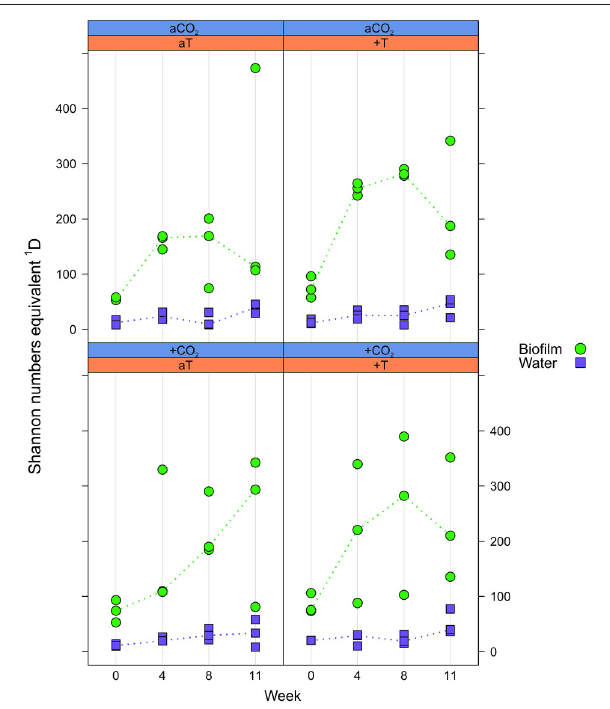
FIGURE 3 | Effective OTU richness. Distribution of Shannon number equivalents 1 D at OTU level concerning Fucus mytili biofilm (green circles) and water samples (blue diamonds) after 0, 4, 8, and 11 weeks of incubation in the benthic mesocosms under different conditions (see Section “Materials